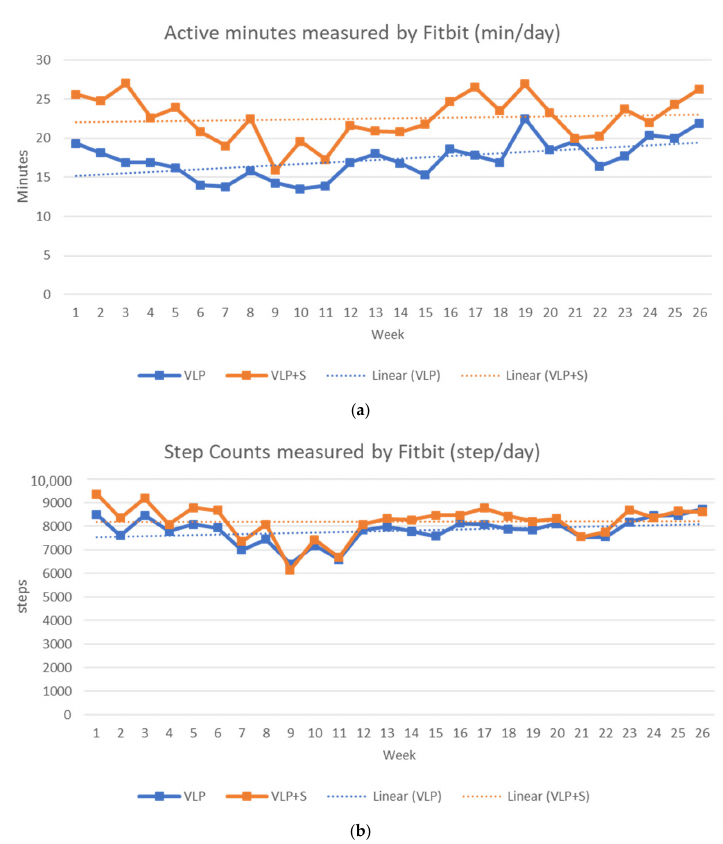
Figure 3. Number of Fitbit-derived active minutes (”fairly active” plus “very active” minutes) and steps per day by intervention group. ( a ) Active minutes measured by Fitbit (min/day); ( b ) step counts measured by Fitbit (step/day); VLP = Vibrant Lives Plus; VLP + S = Vibrant Lives Plus with Support; The program-satisfaction rates of the VLP and VLP + S groups were significantly higher than that of the VLB group for each statement (Table 5). Table 5. Vibrant Lives program satisfaction by intervention group.